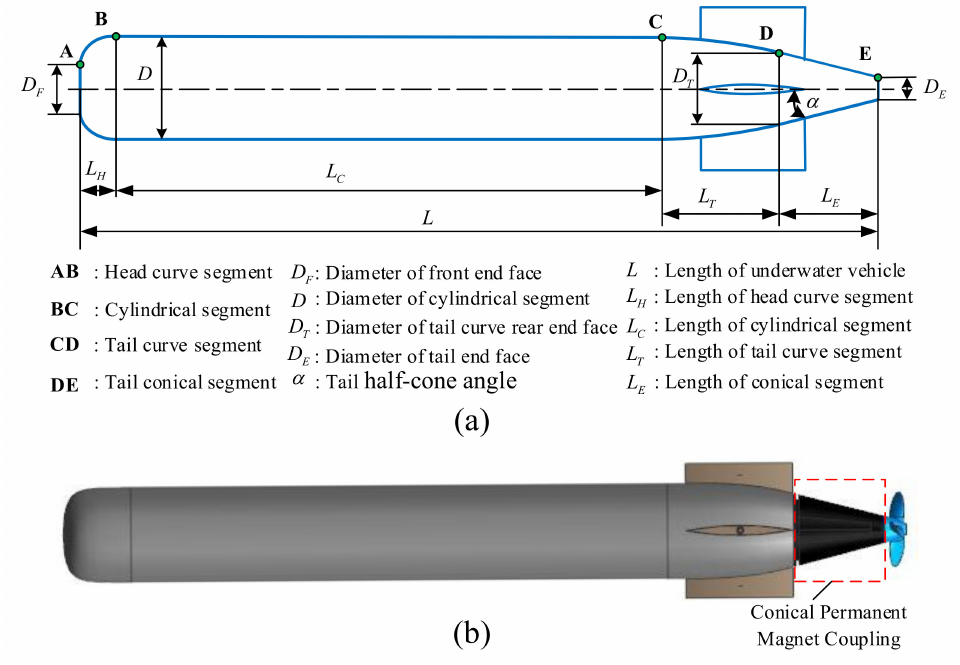
Figure 1. Underwater vehicle. ( a ) Parameters of line type. ( b ) Installation position of